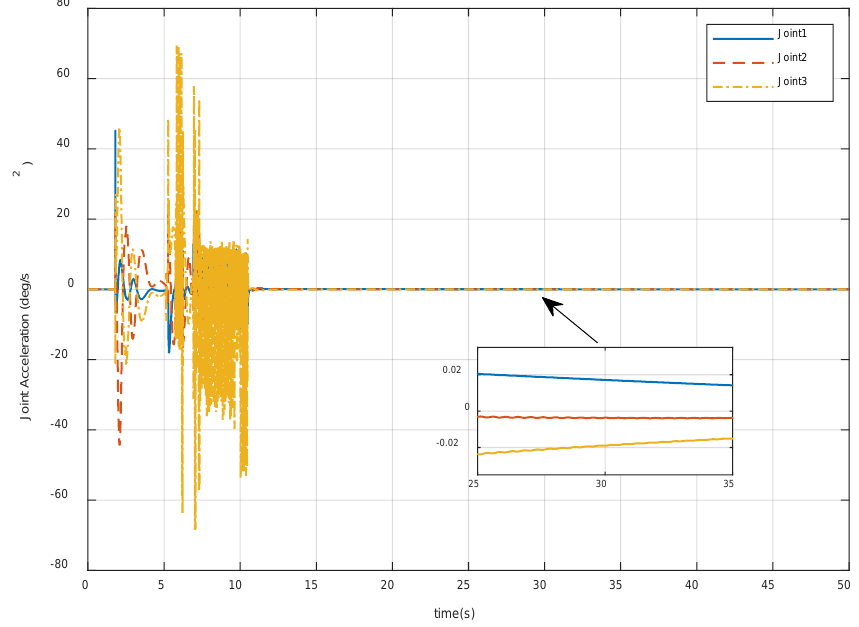
Figure 20. Variation of the manipulator joint accelerations.